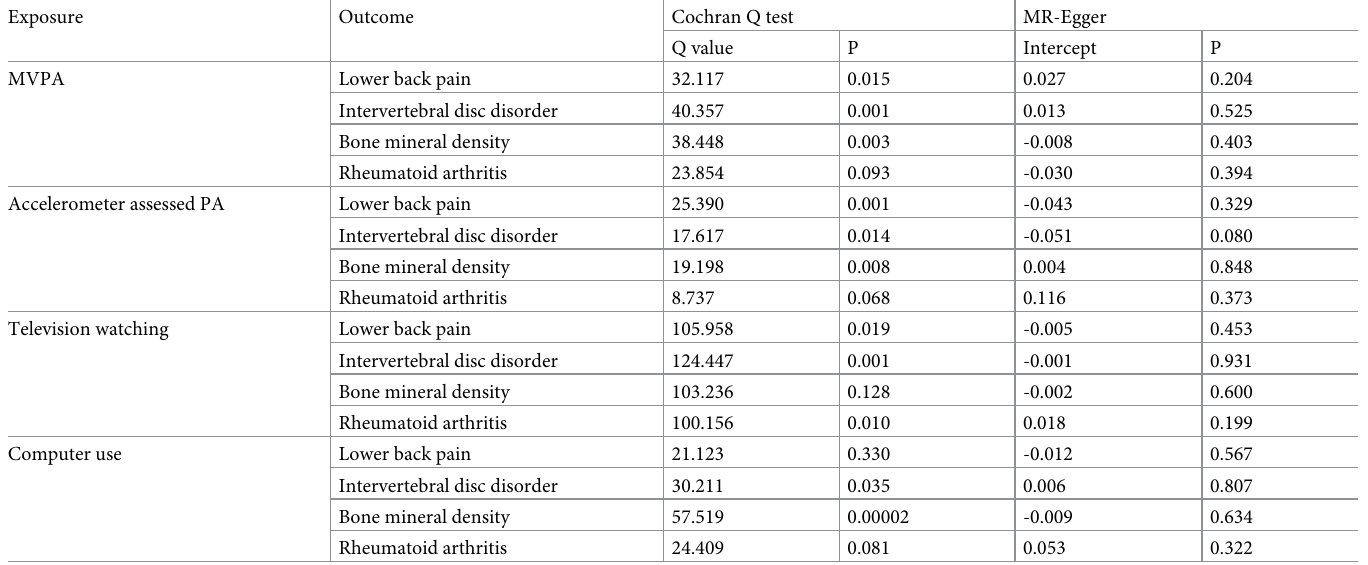
Table 2. Sensitivity analysis of the causal effects of LSB/PA on musculoskeletal